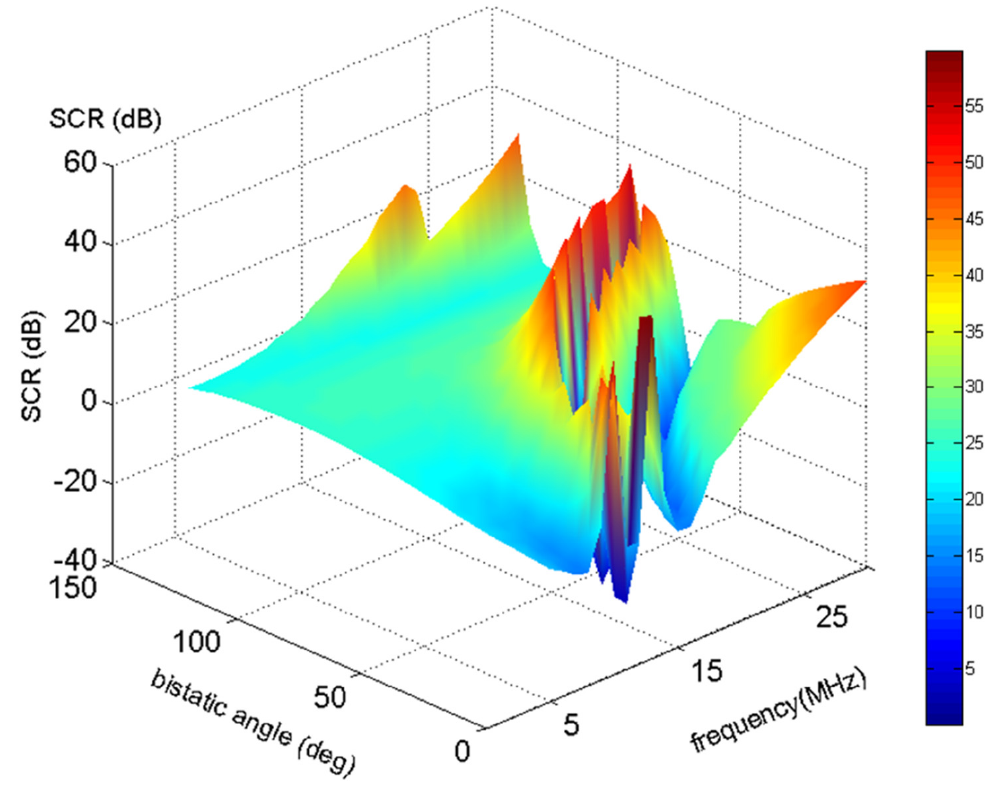
Figure 47. The signal-to-clutter ratio measures the detectability of ship echoes and varies strongly with radar frequency and the bistatic scattering geometry. This kind of radar-generated display can be used more generally to advise a network of OTH radars on how to optimise resource allocation. Tourism, in the form of cruise ships, could, in principle, take advantage of skywave radar measurements of wind and sea conditions, though these vessels are usually fitted with stabilisers so only very rough seas affect passenger comfort and